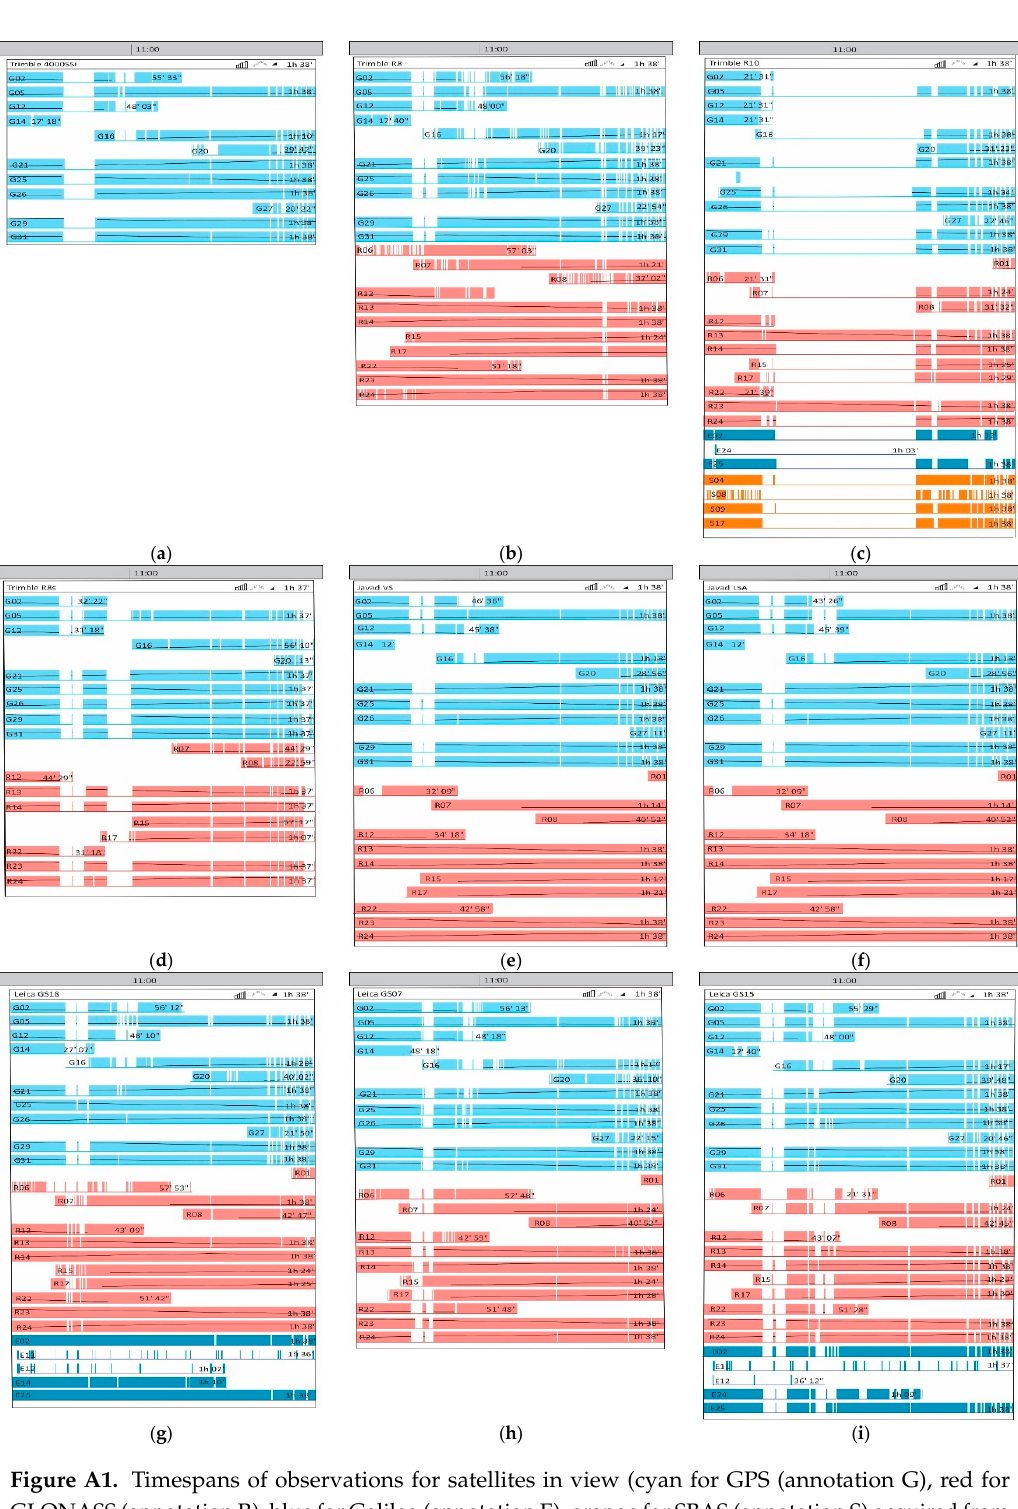
Figure A1. Timespans of observations for satellites in view (cyan for GPS (annotation G), red for GLONASS (annotation R), blue for Galileo (annotation E), orange for SBAS (annotation S) acquired from Lieca Infinity 2.3.2 for the receivers: ( a ) Trimble 4000 SSi, ( b ) Trimble R8, ( c ) Trimble R10, ( d ) Trimble R8s, ( e ) Javad Triumph-VS, ( f ) Javad Triumph-LSA, ( g ) Leica GS18, ( h ) Leica GS07, and ( i ) Leica GS15. Times refer to local time, which is UTC+2h. The black lines in each particular satellite timespan show the elevation angles of the satellite.